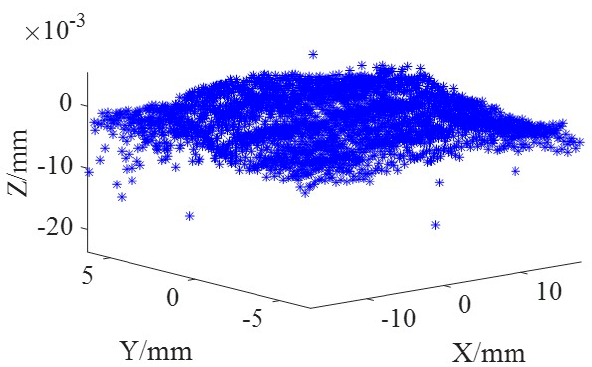
Figure 9. Point cloud of 3D error generated by LSM.